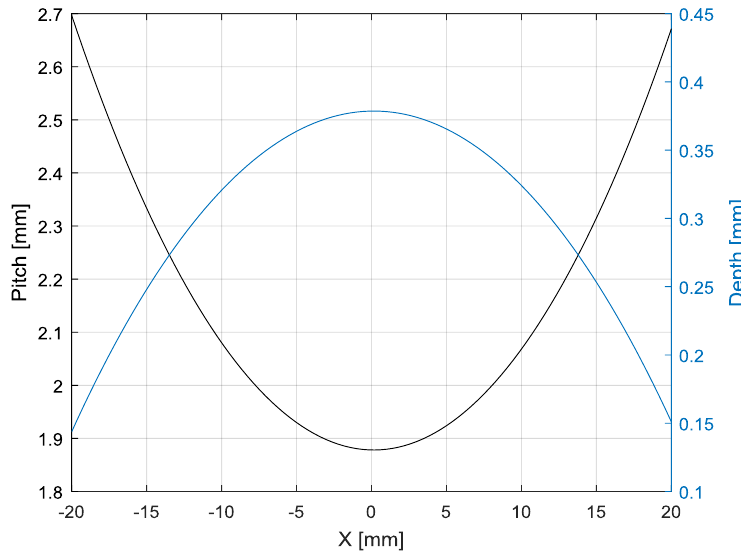
Figure 4. Pitch and depth progression to normalize ball speed curve.